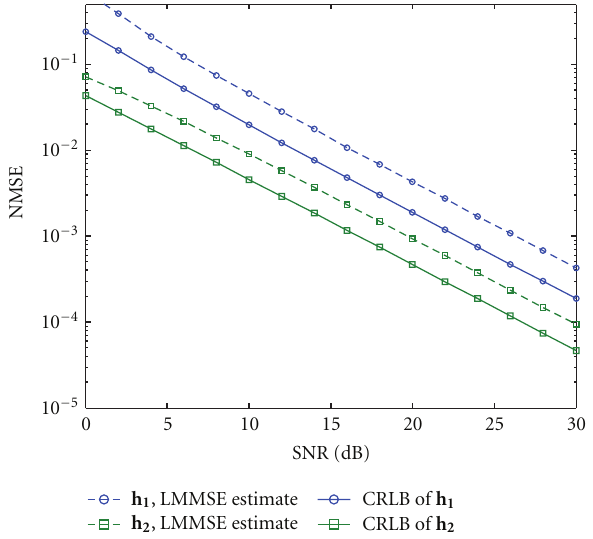
Figure 8: Modified LMMSE channel estimation NMSEs versus SNR for α =